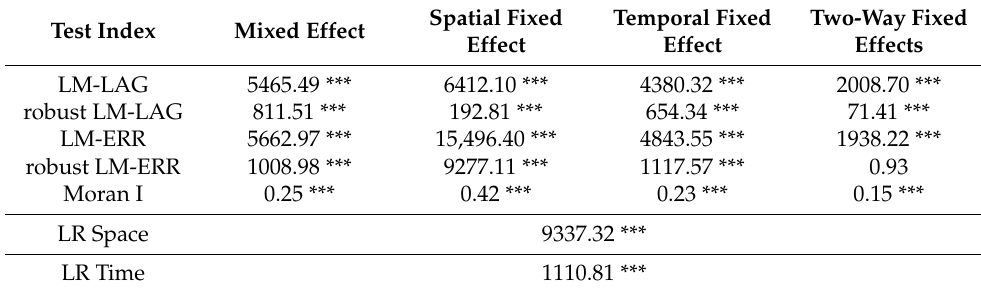
Table 2. Moran’s I Index and Lagrange Multiplier Test